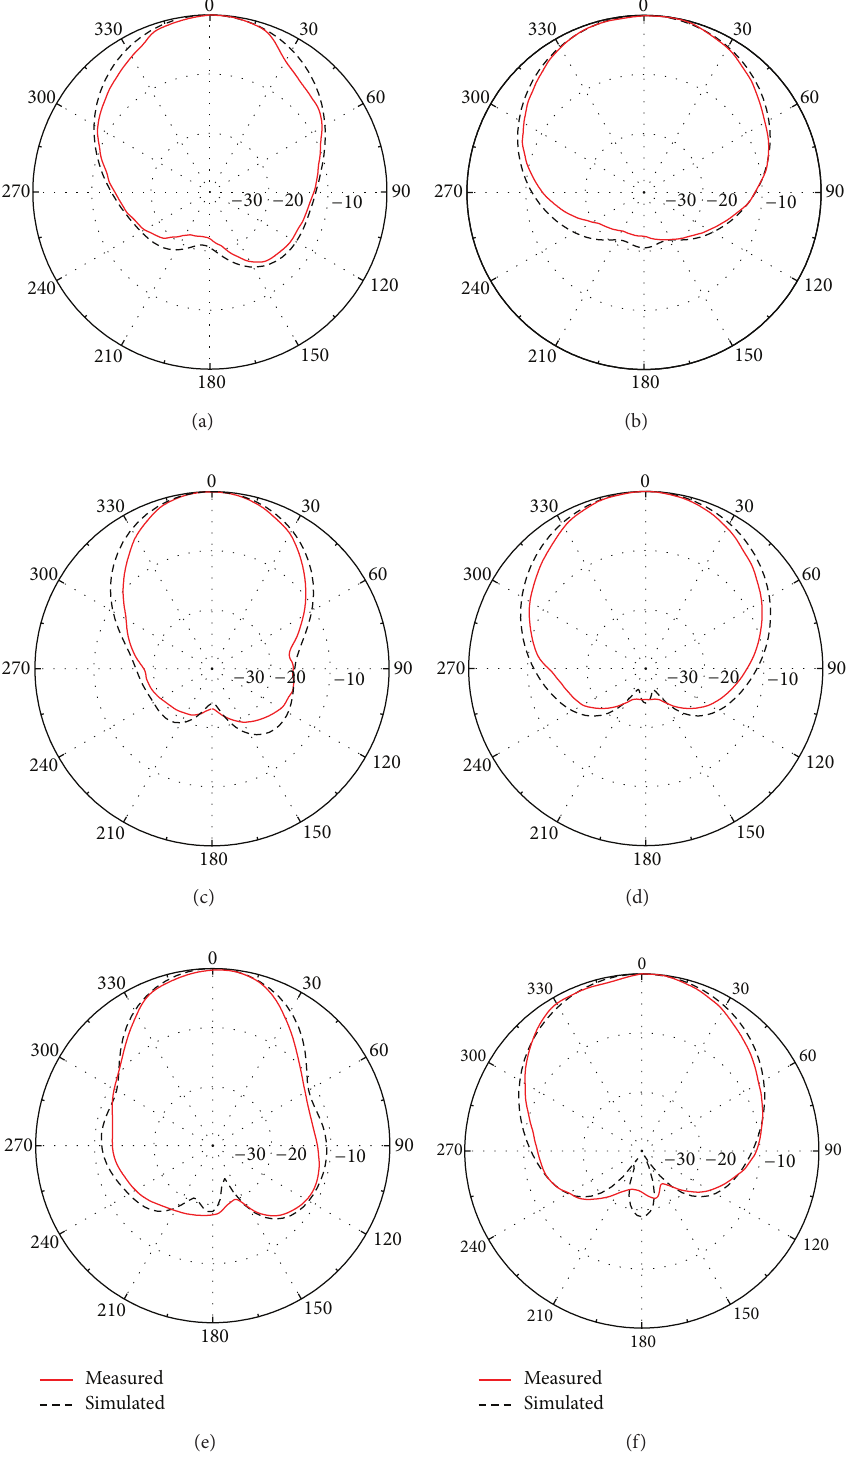
Figure 4: Simulated and measured radiation patterns of proposed antenna. (a) 33 GHz, 𝑥𝑧 -plane; (b) 33 GHz, 𝑦𝑧 -plane; (c) 35 GHz, 𝑥𝑧 -plane; (d) 35 GHz, 𝑦𝑧 -plane; (e) 37 GHz, 𝑥𝑧 -plane; and (f) 37 GHz, 𝑦𝑧